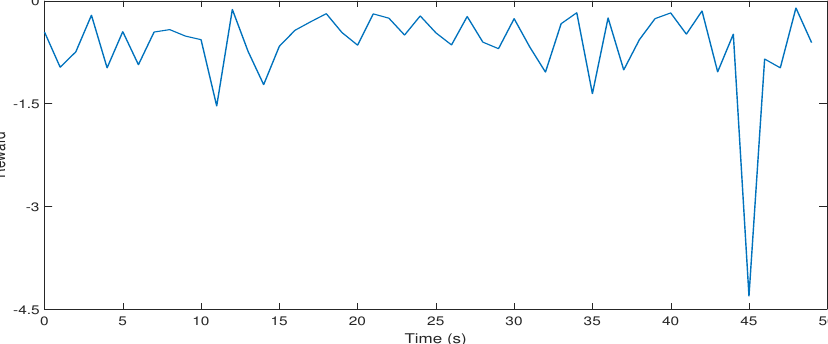
Figure 20. The variation curve of negative Q value in the presence of disturbance.